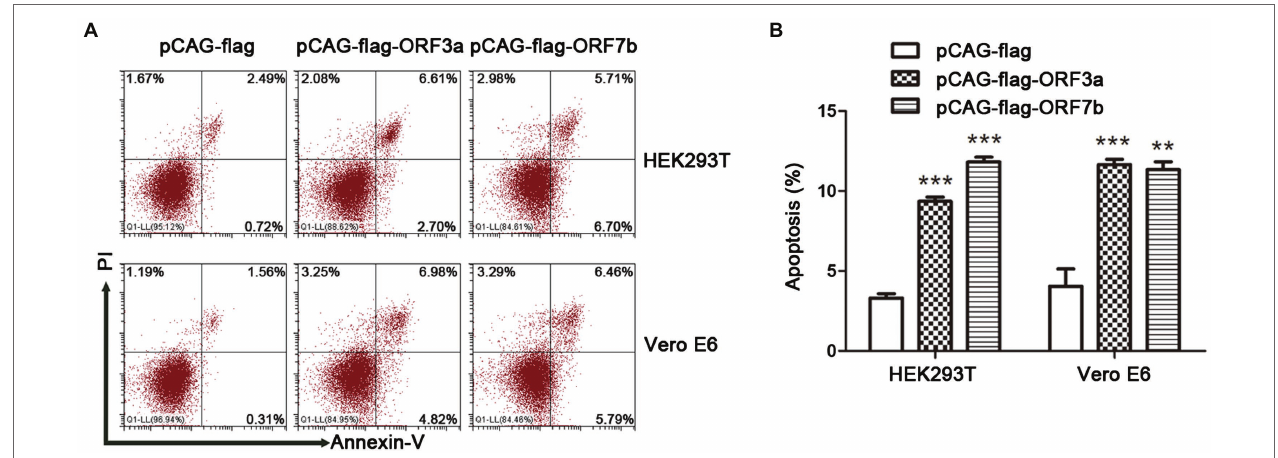
FIGURE 1 | ORF7b induces apoptosis in HEK293T and Vero E6 cells. (A) Apoptosis was measured using flow cytometry at 18 h after transfection with pCAG-flag- ORF7b, pCAG-flag, and pCAG-flag-ORF3a groups were set as the negative control and positive control, respectively. (B) The percentage of cell apoptosis was quantified from three independent measurement. ** p < 0.01; *** p < 0.001, compared with the negative control group (one-way ANOVA and Tukey’s post-hoc